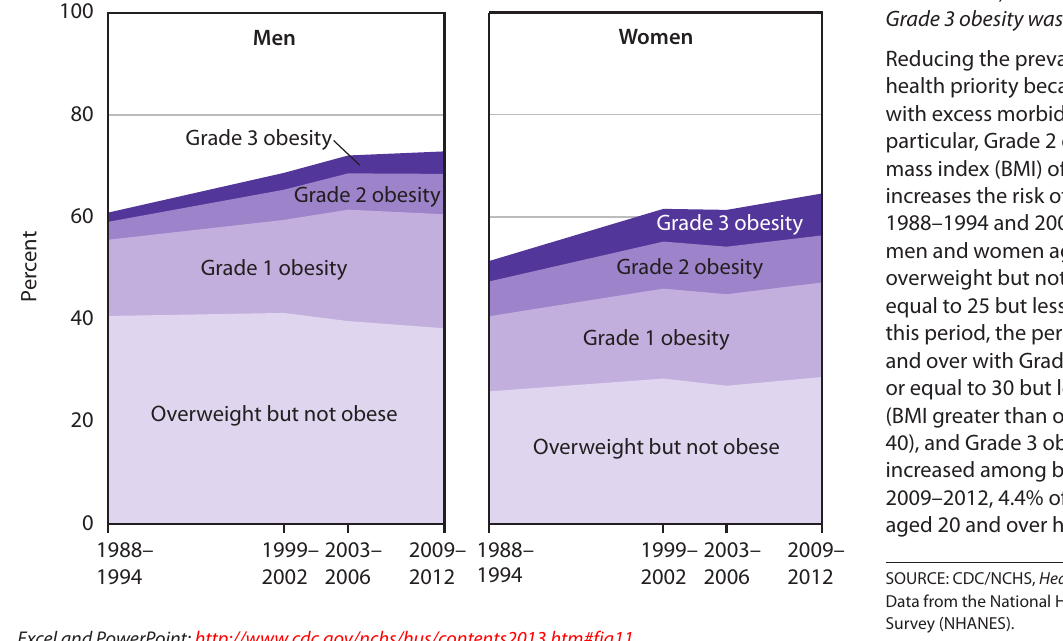
Figure 11. Overweight and obesity among adults aged 20 and over, by sex: